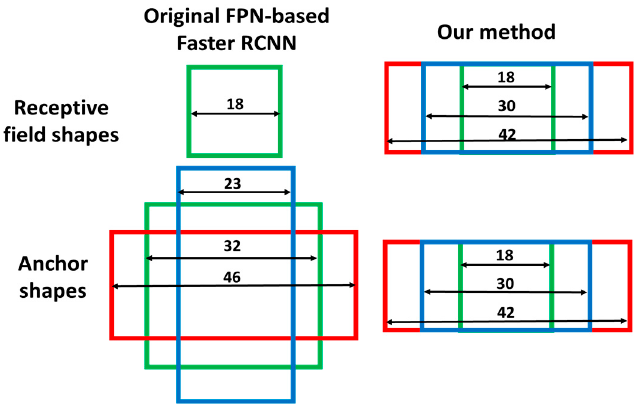
Figure 3. Different receptive field shapes and anchor shapes in P2 .